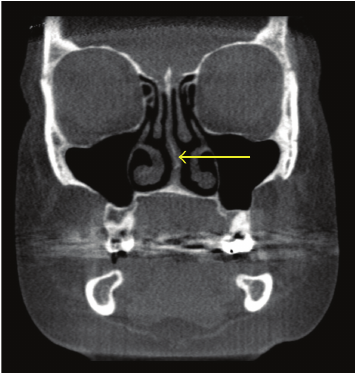
Figure 2: Coronal CT scan demonstrating left nasal septal deviation (arrow). No concha bullosa or sinusitis is